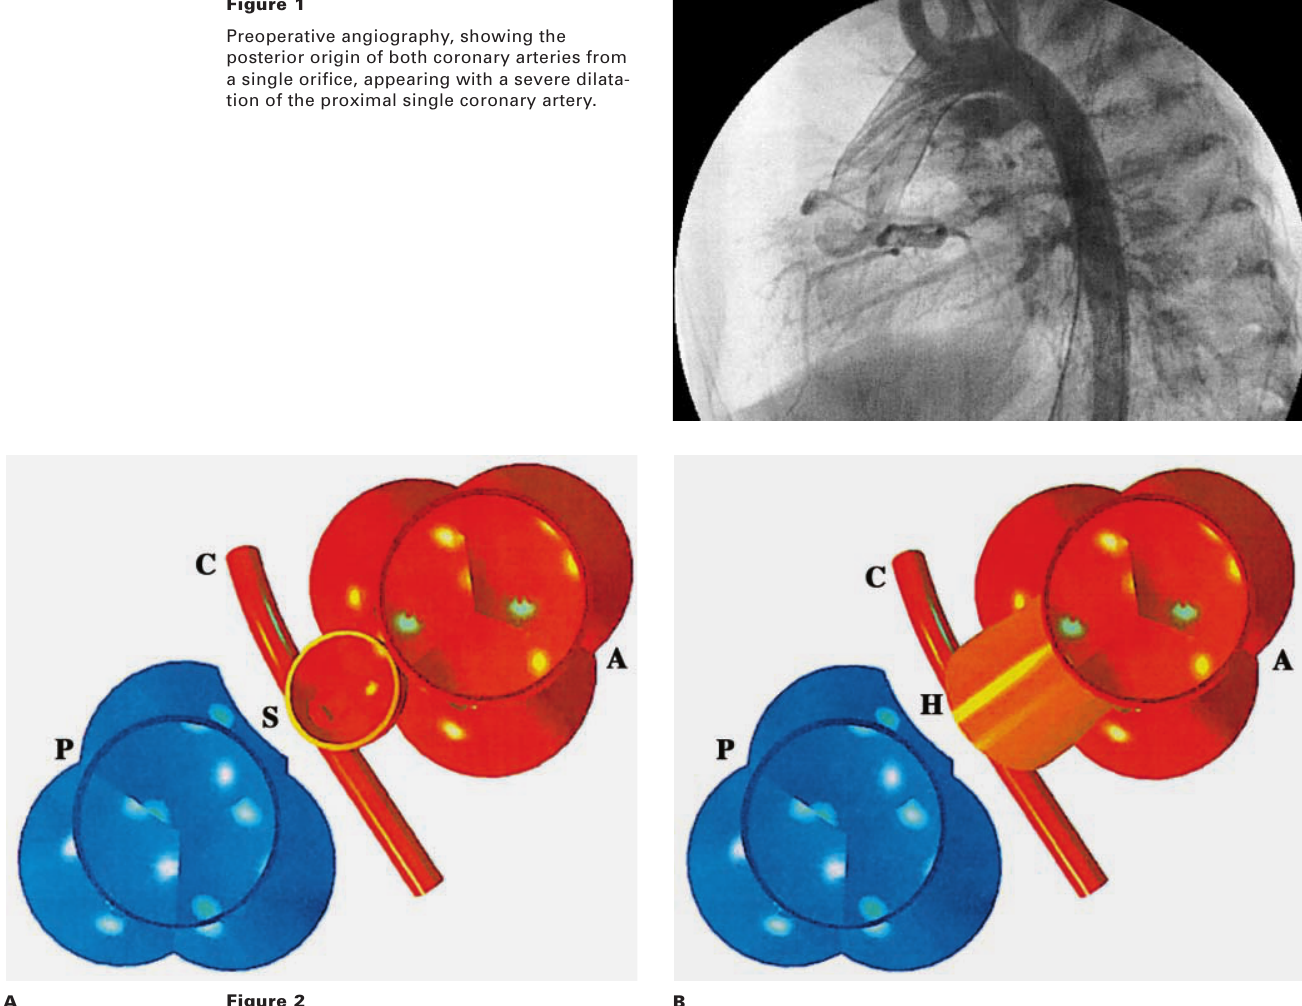
A Computerised drawing of the surgical technique, with a side-to-side connection of the single coronary orifice to the new ascending aorta (A), roofed with autologous pericardial patch (B) in order to construct a para-aortic channel. Blue = old aorta. Red = new aorta. Figure 2 A: A = aorta, C = coronary artery, P = pulmonary artery, S = single coronary orifice Figure 2 B: A = aorta, C = coronary artery, H = pericardial patch, P = pulmonary artery